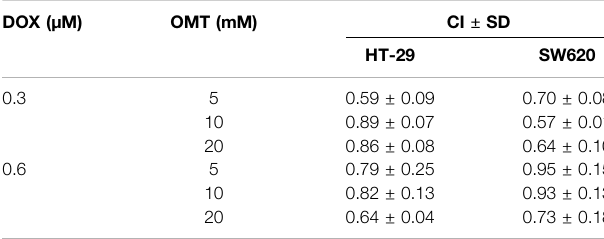
TABLE 1 | Combination index (CI) of HT-29 and SW620